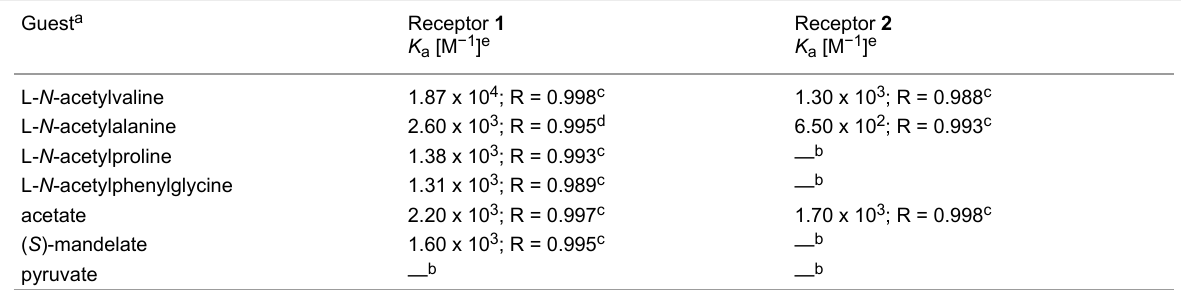
Table 2: Association constants ( K a ) in CH 3 CN from fluorescence measurements.